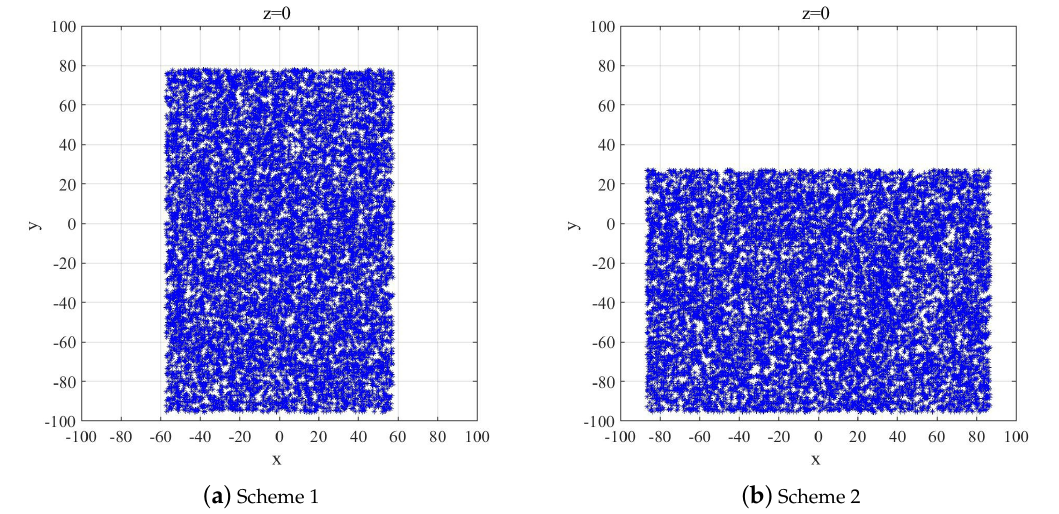
Figure 15. Workspace diagrams of the distribution of spherical hinges for Schemes 1 and